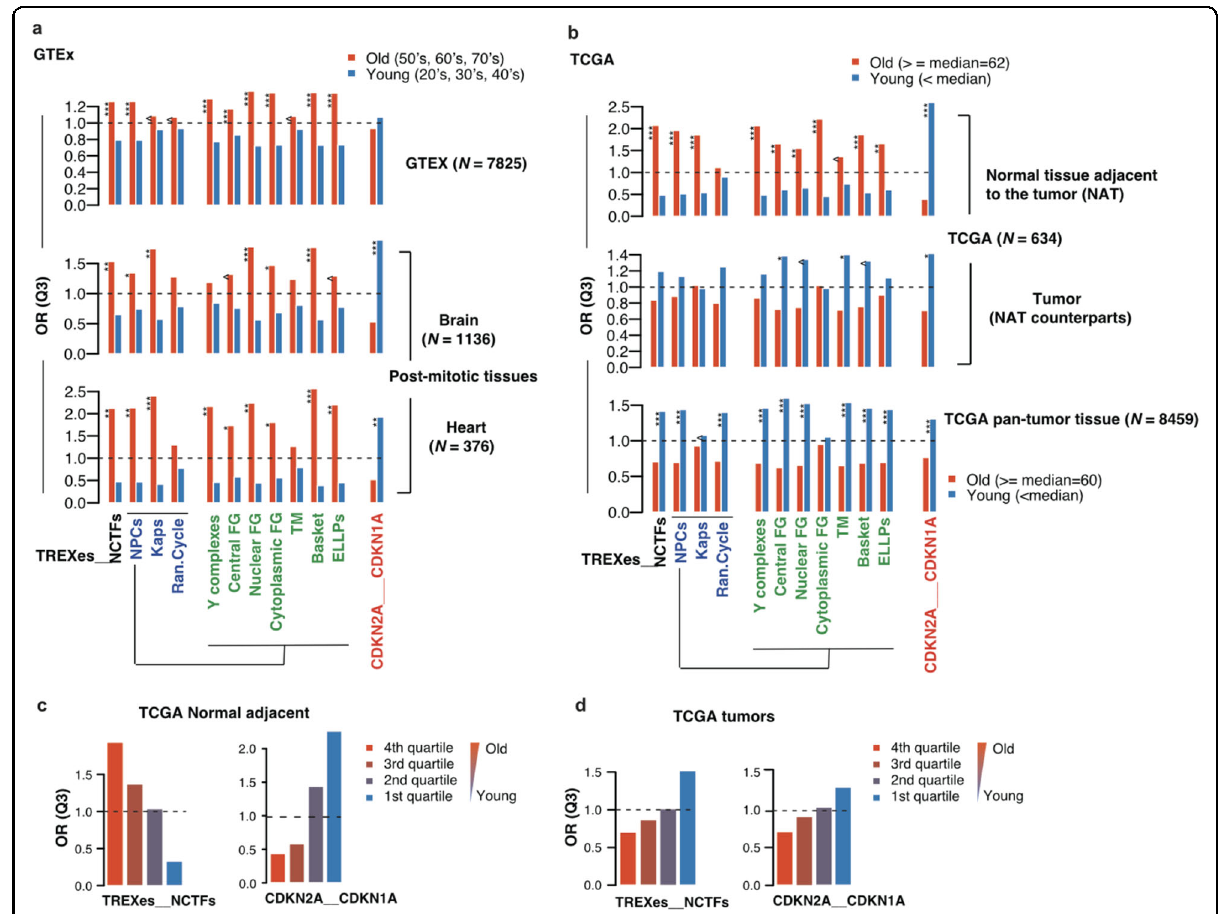
Fig. 4 TREXes and NCTFs show distinctive enrichment patterns in both normal human and cancer during aging. a Comparison of the odds ratios of the TREXes and NCTF subclasses and CDKN2A and CDKN1A in the old and young samples from GTEx. Bar plot representing the odds ratios (ORs, Q3) of the NCTFs or their subclasses and TREXes. The red bar indicates these ORs in old tissue and the blue bar in young tissue. Color legends for the x -axis are the same as those shown in Fig. 1e. Higher ORs indicate a greater likelihood of data being in Q3 (refer to Fig. 1a), signifying under- enrichment. The top graph represents the results from the total number of samples from the GTEx database. Middle and bottom panel show results from the brain and heart tissues, which are postmitotic tissues. b Comparison of the ORs of TREXes and NCTF subclasses and CDKN2A and CDKN1A in the old and young samples from the TCGA database. The top and middle panels show the results from normal adjacent tissues and their tumor counterparts, respectively. The bottom panel shows the results of the total tumor samples. c , d Findings shown in ( b ) based on age